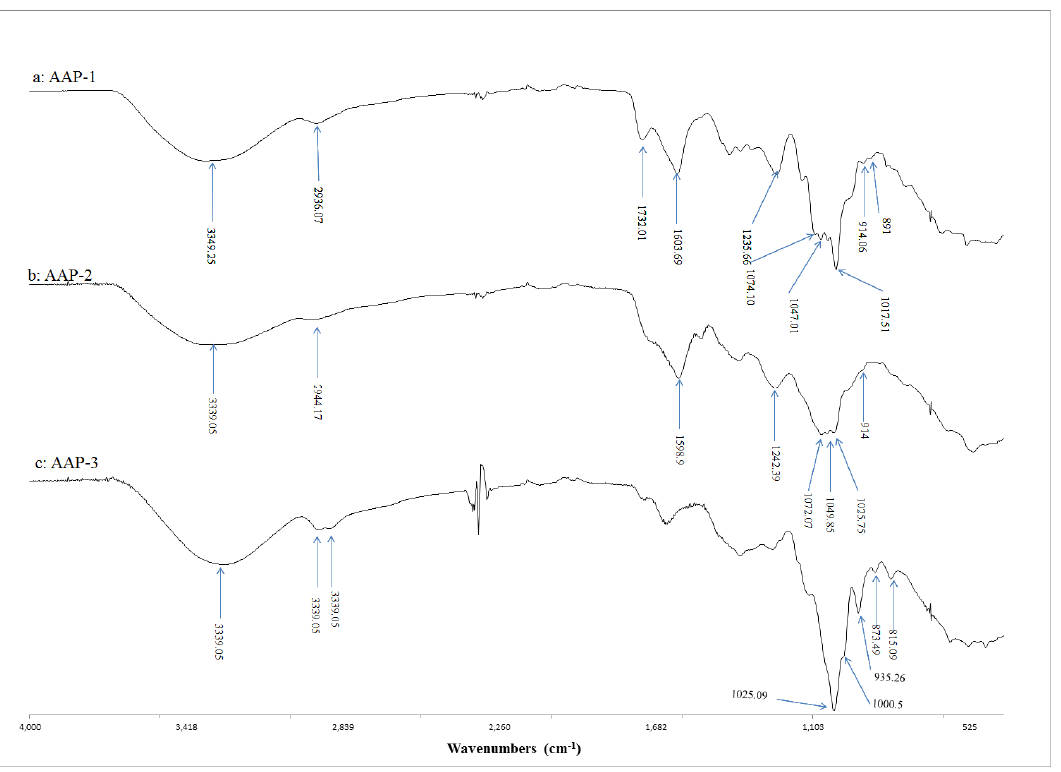
Figure 4. FTIR spectra of the three fractions from A . annua. ( a ): AAP-1, ( b ): AAP-2 and ( c ): AAP-3.